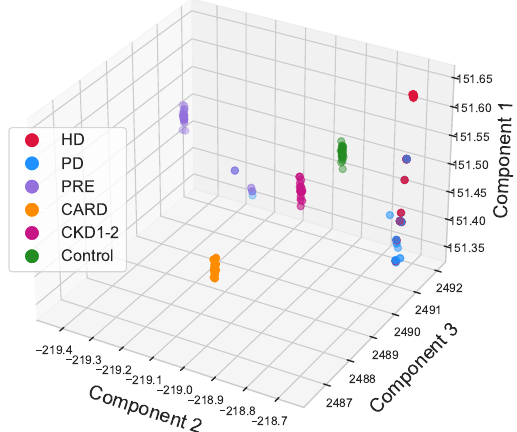
Figure 5. Kernel Fisher Discrimination Analysis results. Local clusters of patients from the same group are